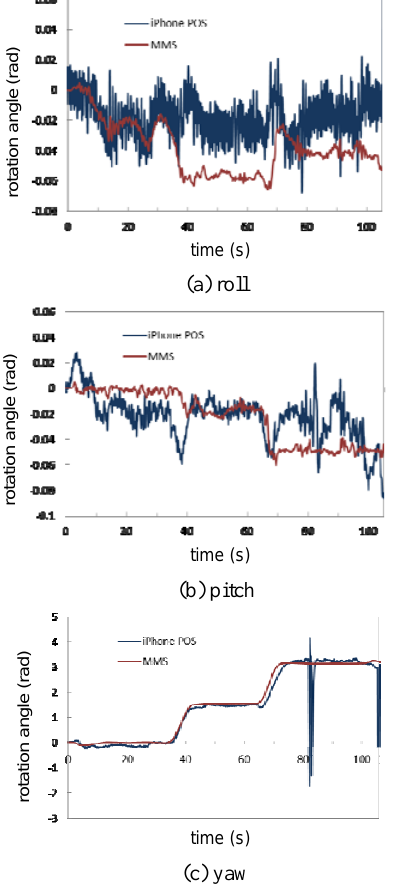
Figure 7. Results of rotation angle with POS sensor fusion The displacement between estimated value and MMS data with respect to roll, pitch, and yaw is 0.024 (rad), 0.031 (rad), and 0.17 (rad) on average, respectively. In the result of yaw, the gap was large, because of limitation of function in iPhone, that is negative value of yaw angle is converted to zero automatically.